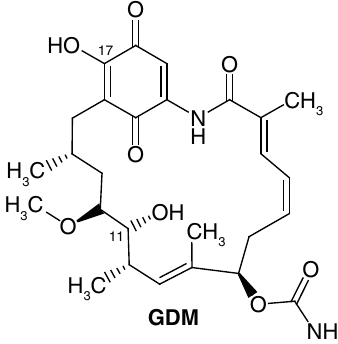
Figure 1. Structure of geldanamycin. The carbon atom C-11 and C-17s of the macrocycle of the geldanamycin are numerically